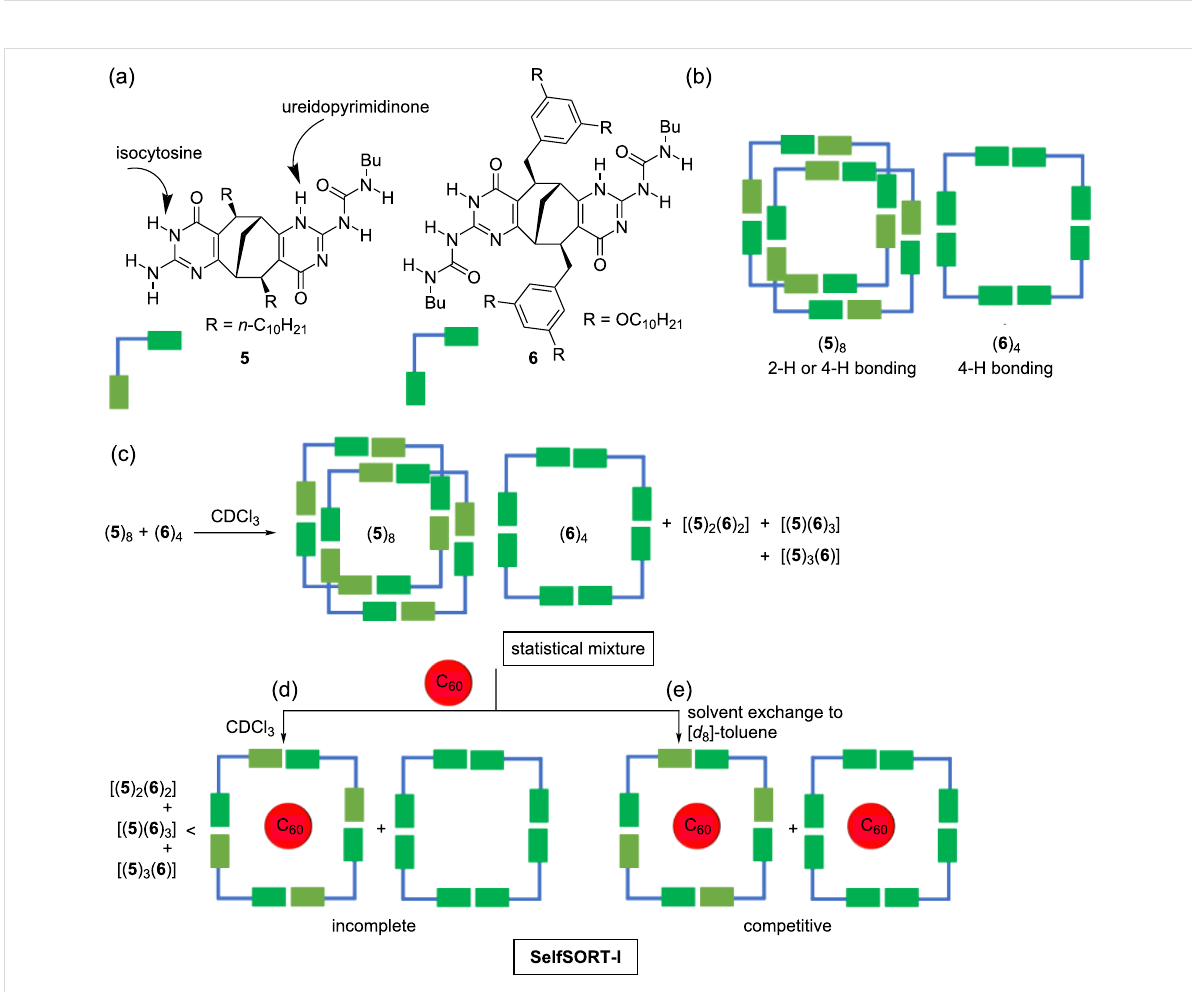
Figure 4: (a) The monomers 5 and 6 and their H-bonding array. (b) The hydrogen-bonded octameric and tetrameric tubes. (c) A representation of the complex mixture after combining the monomers 5 and 6 in CDCl 3 . (d) The partial separation of the mixture upon the selective C 60 complexation by monomer 5 . The guest-induced rearrangement results in an incomplete self-sorted mixture. e) A solvent change from CDCl 3 to [ d 8 ]-toluene leads to a 2-fold completive self-sorting upon treatment with C 60